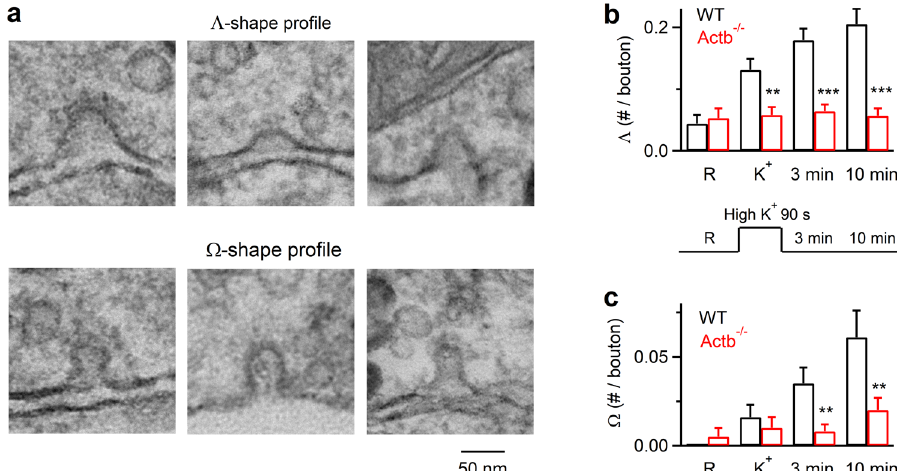
Fig. 2 Reduction of Λ -pro fi le formation in hippocampal boutons lacking β -actin. a Sampled EM images showing the fl at membrane, Λ -shape, and Ω -shape membrane at hippocampal boutons. The tip of Λ -shape pro fi le could be either pointed or dome-like. b The number of Λ per bouton before (R) and after KCl application in wildtype (WT) or TM4d-Actb − / − synapses (mean + SEM; each group was from 40 – 100 synaptic pro fi les from 5 – 7 cultures; each culture was from 4 – 6 mice). p values are 0.678, 0.001, 4.04× 10 − 8 , and 3.87 ×10 − 9 for R, K + , 3 min and 10 min group, respectively (*** p < 0.001; ** p < 0.01; * p <0.05, two-tailed unpaired t -test, compared to WT). A schematic showing stimulation and culture fi xation time is also shown (lower): EM images were obtained from four conditions in which chemical fi xation was applied in the resting condition (R), immediately after 1.5 min application of 90 mM KCl (K + ), 3 min or 10 min after KCl application. c The number of Ω per bouton before (R) and after KCl application in wildtype (WT) or TM4d-Actb − / − synapses (mean + SEM; each group was from 40 – 100 synaptic pro fi les from 3 – 8 cultures; each culture was from 4 – 6 mice). p values are 0.298, 0.465, 0.002, and 0.006 (two-tailed unpaired t -test, compared to WT) for R, K + , 3 min and 10 min group, respectively. Source data are provided as a Source Data fi